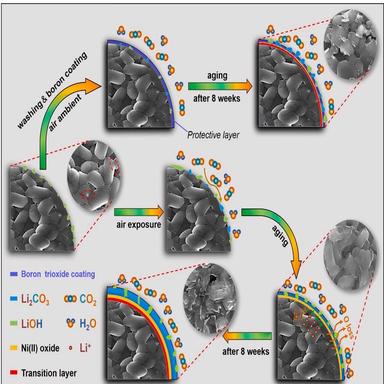
Schematic diagram of surface deterioration mechanism of NCM811 cathode materials with various treatments after storing in ambient air.